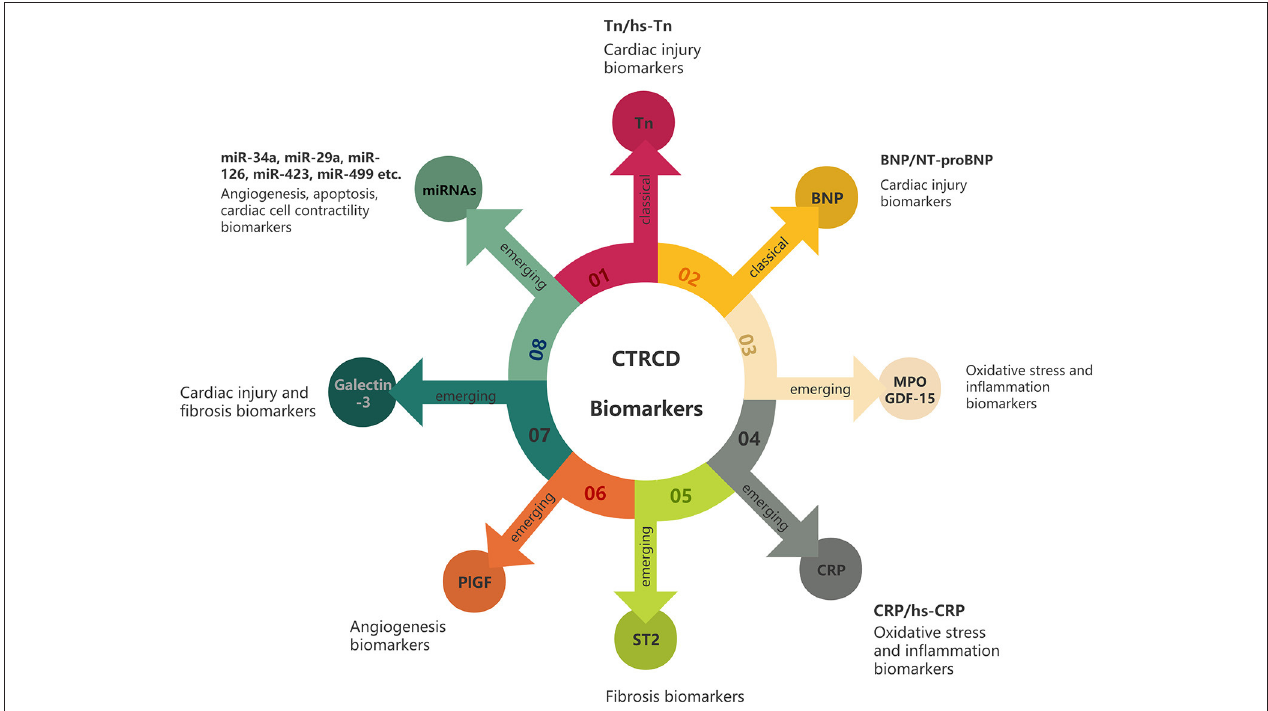
FIGURE 1 | CTRCD biomarkers. Classic biomarkers include Tn and BNP, which mainly reflect cardiac injury. Emerging biomarkers include MPO, GDF-15, CRP, ST2, PlGF, galectin-3 and miRNAs. They can reflect various aspects of the pathophysiology of the heart after cancer treatment, such as oxidative stress, inflammation and